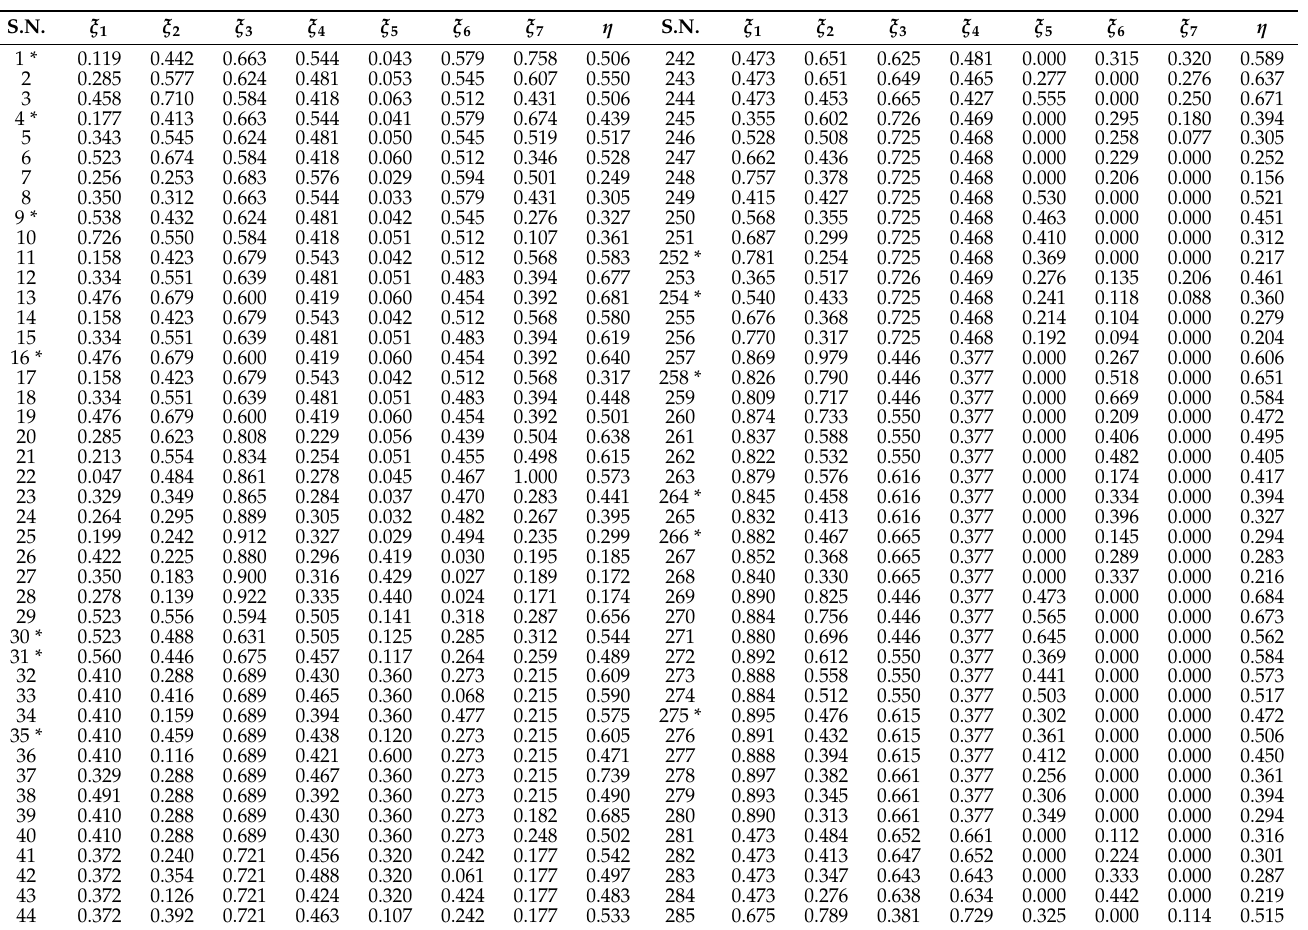
Table A1. The Normalized Data for Training and Testing the ANN. Marked with * at the Serial Numbers Are Those for